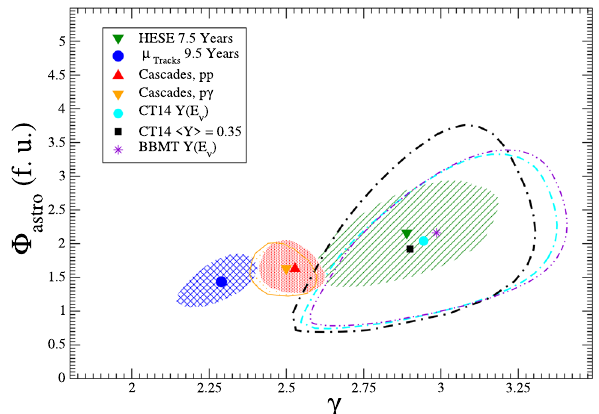
Fig. 8 Results for the likelihood analysis of the number of neutrino events observed in the IceCube during six years of exposition of the HESE data (dashed lines) considering three different approaches for the treatment of the average inelasticity at the primary neutrino interaction at the detector. For completeness, the results from Ref. [32] are also